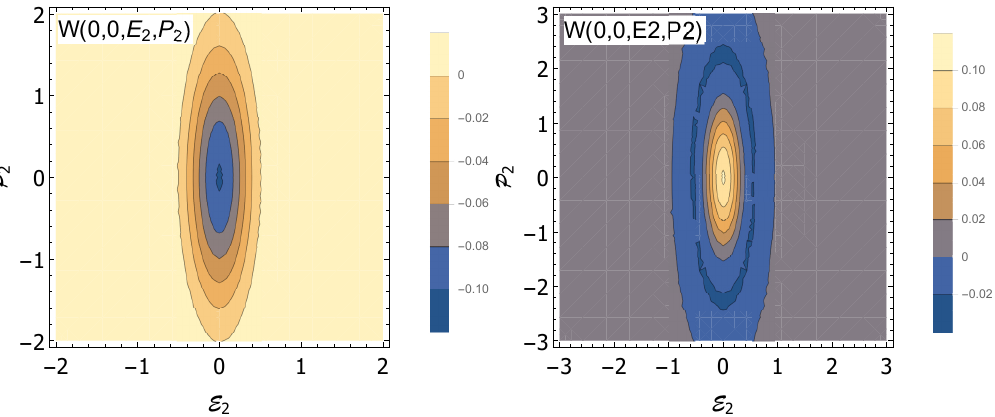
Figure 3. Plots of the Wigner distribution on the phase space for quantum vortices of order 1 ( left ) and 2 ( right ) with a squeezing factor s =